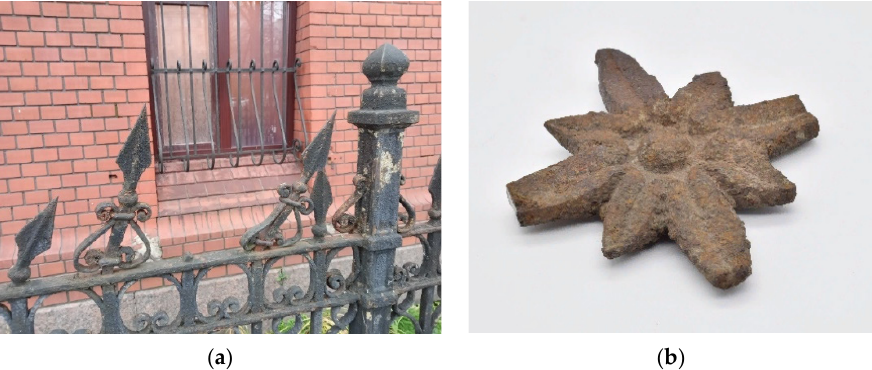
Figure 5. ( a )—An example of a damaged cast-iron fence; ( b )—cast-iron star for repairing.